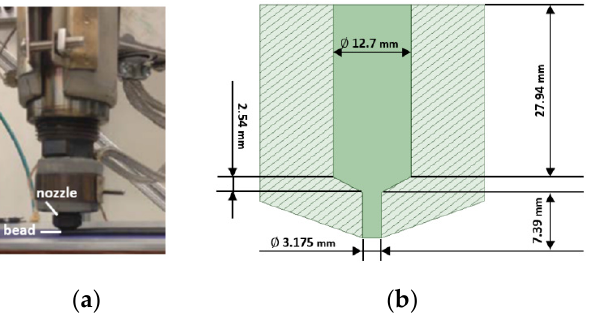
Figure 2. ( a ) Polymer composite deposition process; ( b ) dimensions of extrusion die mounted on the Strangpresse Model 19 extruder (solid shaded region is the flow domain inside the nozzle).